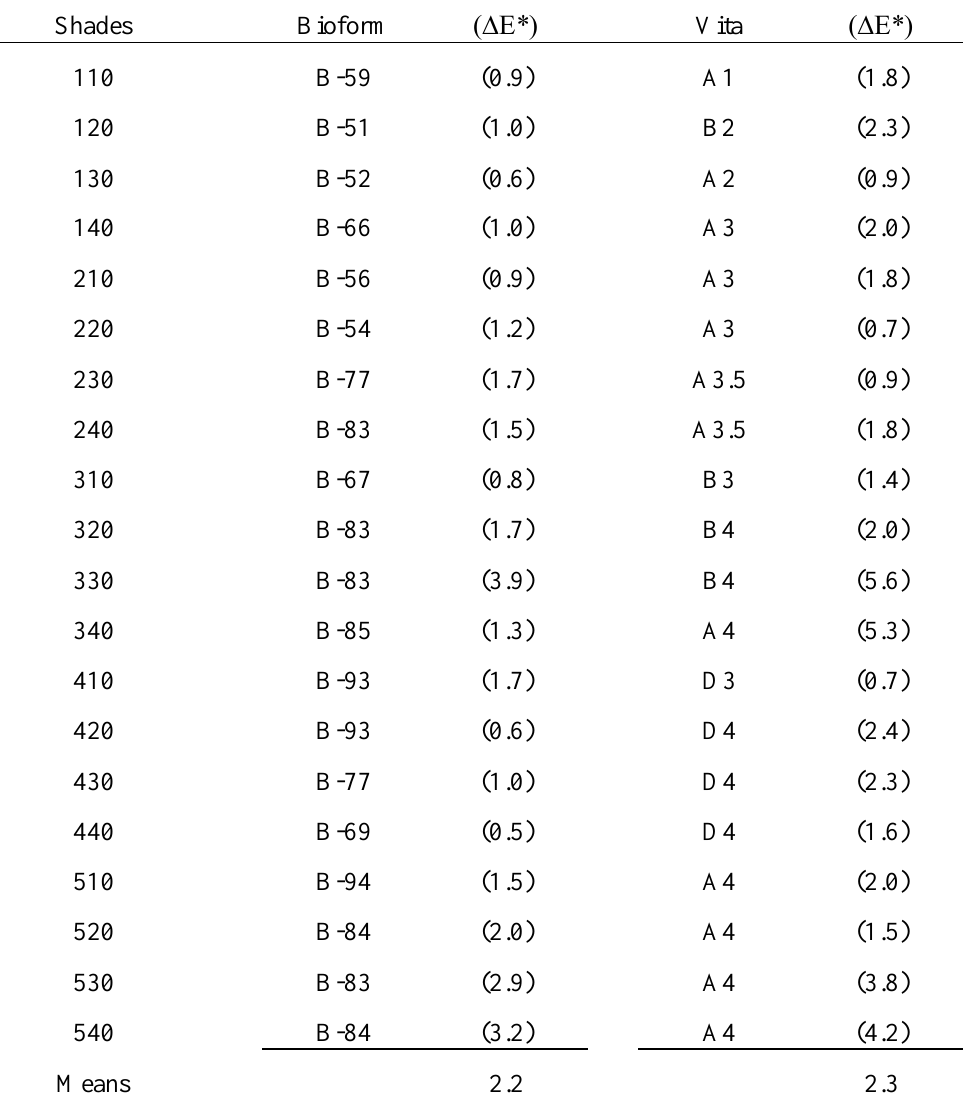
Table 2. Closest match, ∆E*, of Chromascop master shades compared to Bioform and Vita master